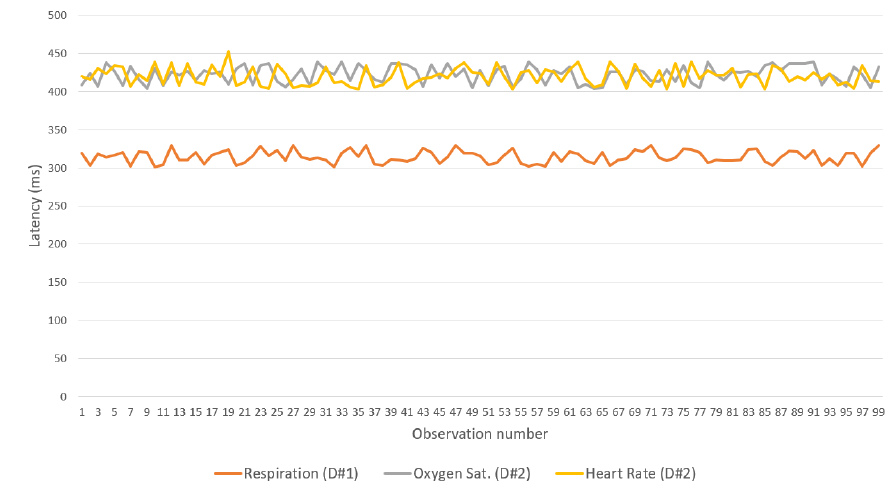
Figure 15. Latencies in the use of CoAP over Wi-Fi (IoMT devices<->Gateway).